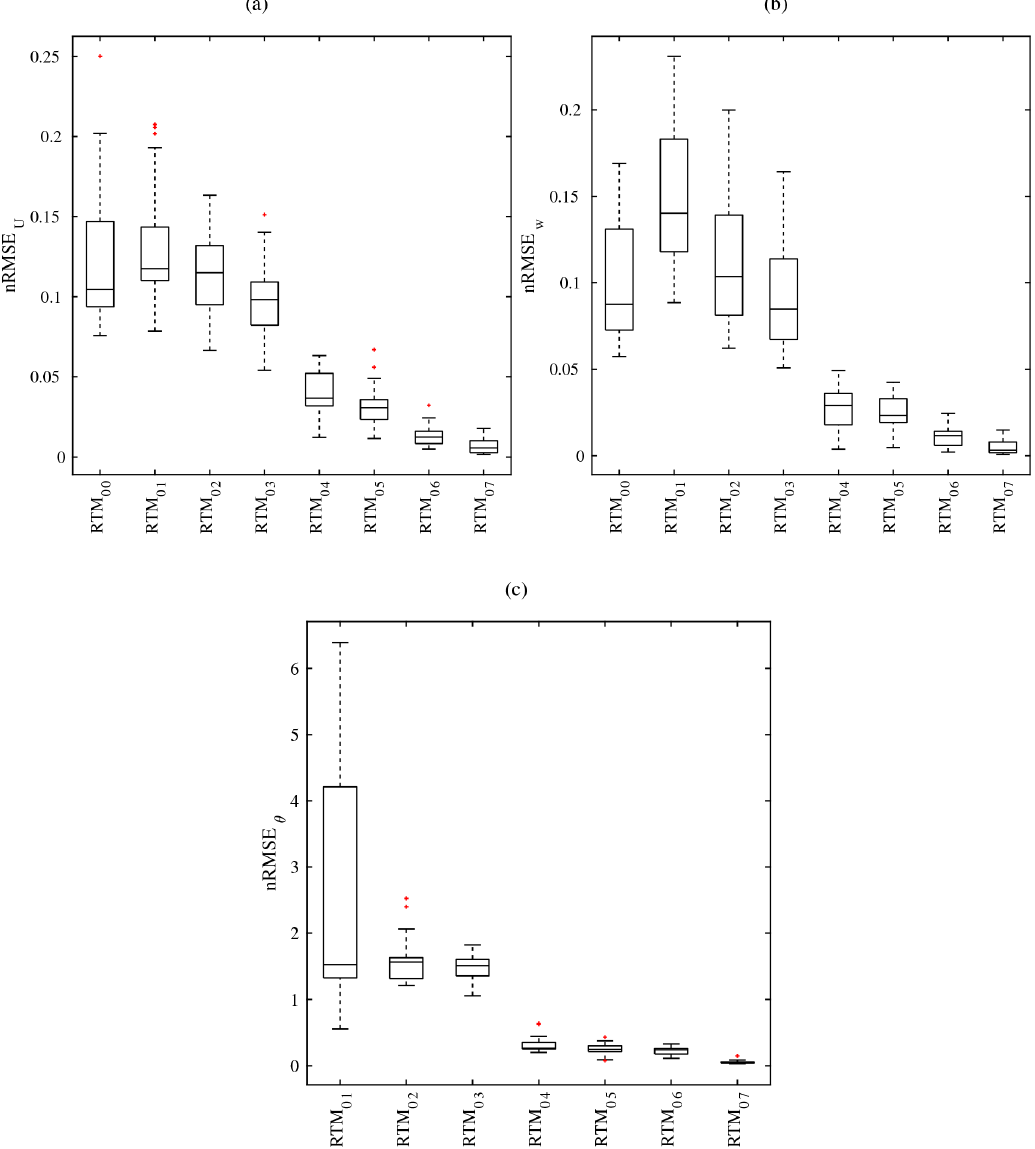
Figure 23. Box plots of the error measure, nRMSE, for (a) the horizontal wind speed (cid:104) U h , r (cid:105) = (u 2 + v 2 ) 1 / 2 , (b) the vertical wind speed (cid:104) w (cid:105) , and (c) the air potential temperature (cid:104) θ (cid:105) for the focus domain of the simple urban configuration. For each parameter, nRMSE is calculated hourly for 1d (1 July) for each RTM